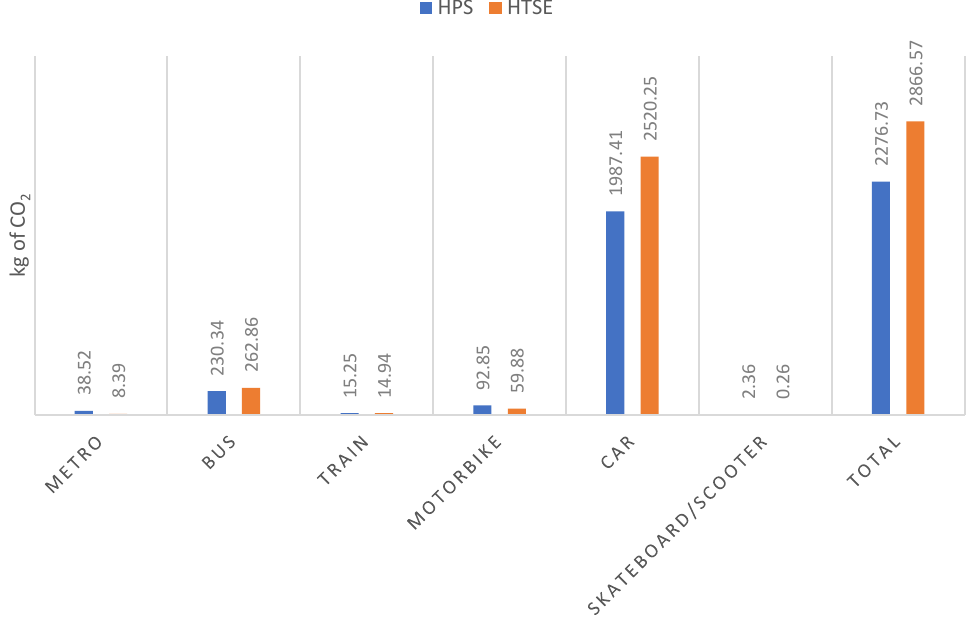
Figure 10. CO 2 emissions/week of the samples.